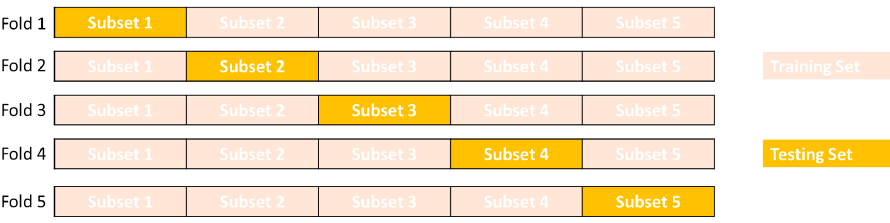
Figure 5. This figure demonstrates training and testing sets assigning in 5-fold cross-validation.